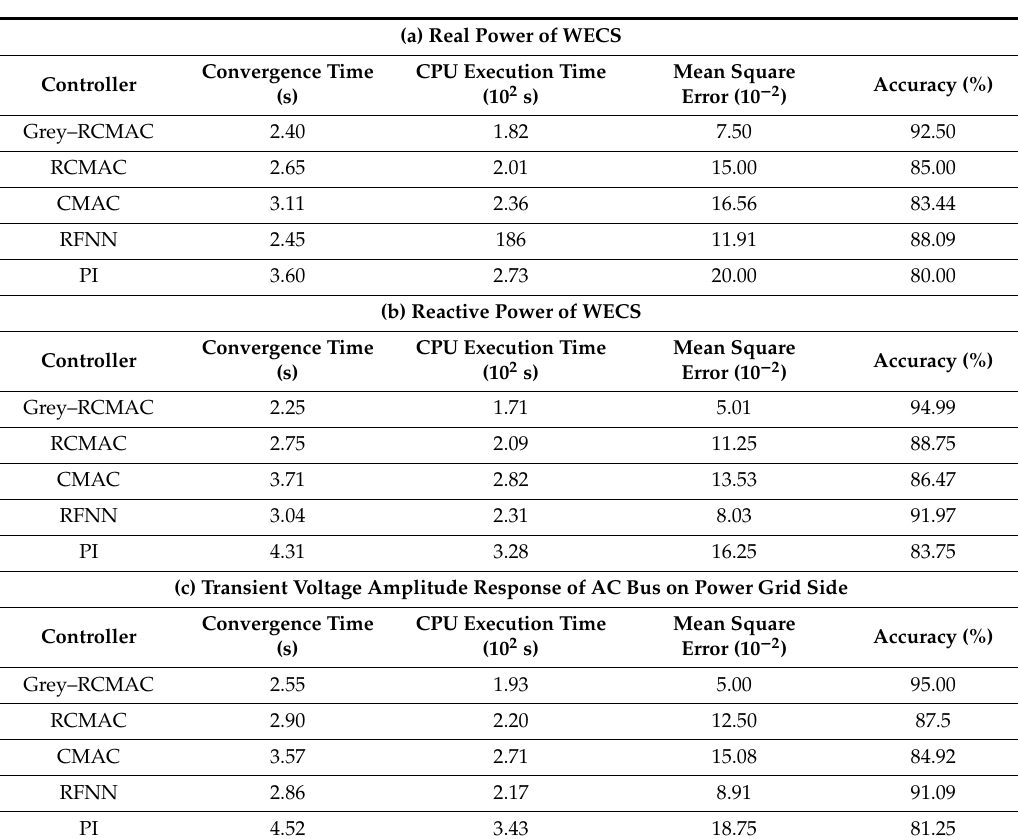
Table 4. Comparison for five controllers when a fault occurs: (a) real power of WECS, (b) reactive power of WECS, and (c) transient voltage amplitude response of AC bus on power grid